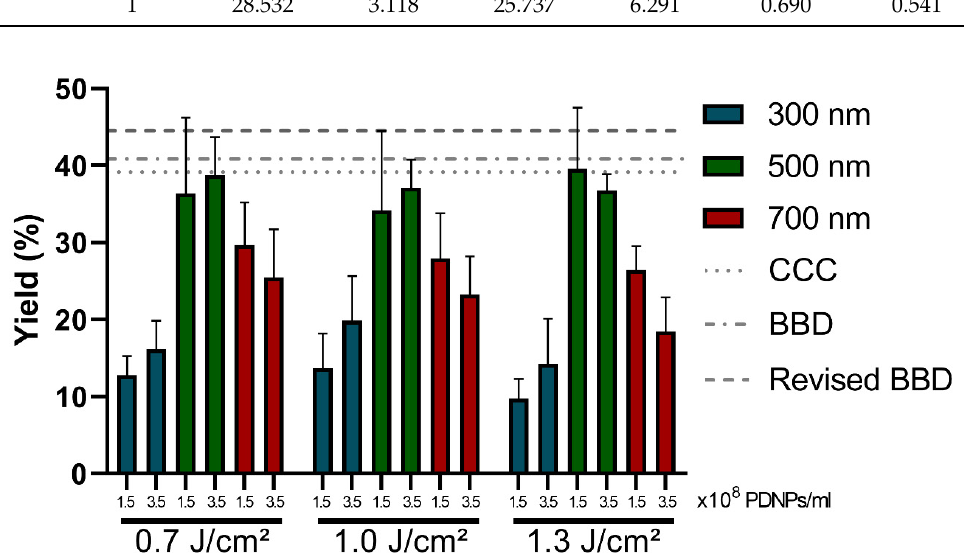
Figure 5. Comparison of the delivery yield experimentally obtained at different factor level combinations. Yield in the function of different PDNP sizes, PDNP concentrations and laser fluences, showing